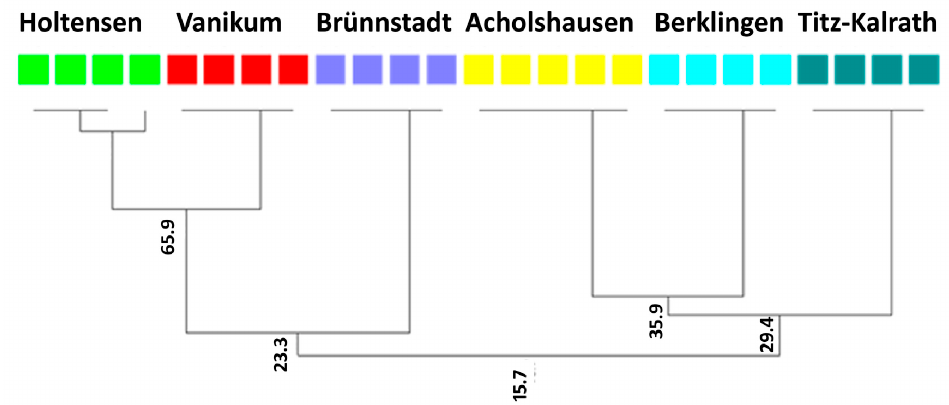
Figure 4. UPGMA clustering based on the Jaccard similarity coefficient, showing the genetic differ- ences in vap1 patterns among six populations of H. schachtii based on DGGE profile analysis. Each color represents vap1 profiles from one population. Bootstrap values refer to the similarity percentage of vap1 patterns within and among populations. Table 1. Similarities of the vap1 patterns among six populations of H. schachtii originating from three geographic regions (Berklingen and Holtensen/Lower Saxony; Titz-Kalrath and Vanikum/North Rhine Westphalia; Acholshausen and Brünnstadt/Bavaria). Compared Populations vap1